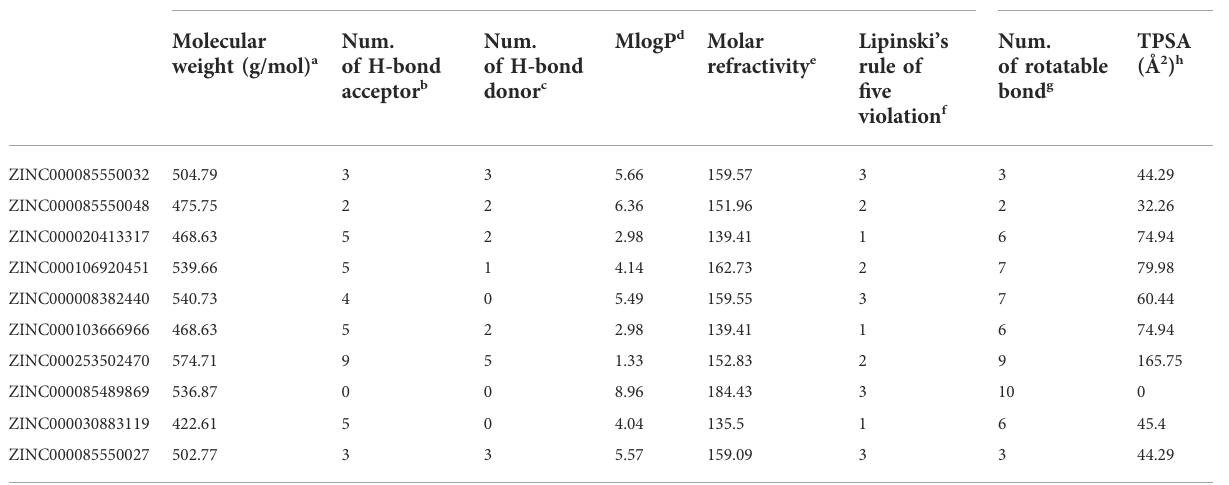
TABLE 3 Table showing the ADME result by using SwissADME. Molecule Lipinski ’ s fi lter Veber ’ s fi lter Num. Molecular of H-bond weight (g/mol) a acceptor